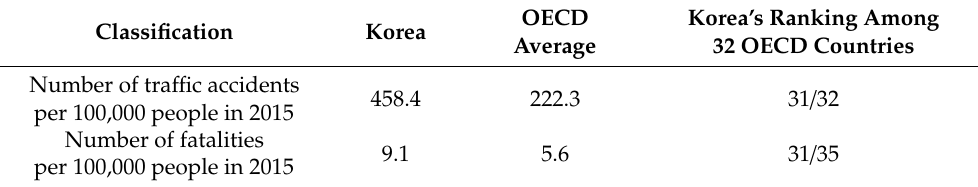
Table 1. Comparison of pedestrian–vehicle fatalities between Korea and OECD countries